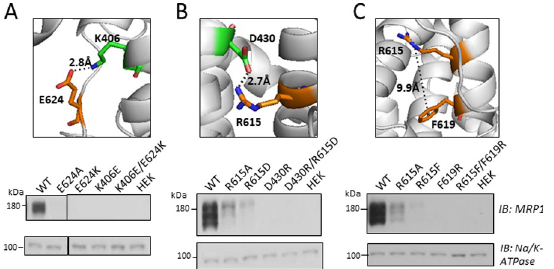
Fig 5. Potential bonding interactions of CR1 Arg 615 and Glu 624 and effect of structure-guided double exchange mutations on MRP1 levels. Upper panels , Shown are potential electrostatic bonding interactions between (A) Lys 406 and Glu 624 ; and (B) Arg 615 and Asp 430 , and (C) Arg 615 and Phe 619 derived from an atomic homology model of human MRP1 [43] based on the apo bovine Mrp1 cryo-EM structure (PDB ID: 5UJ9). While several bonding interactions are theoretically possible, for clarity, only the potential bond ( dotted line ) with the shortest predicted distance between each pair of amino acids is shown. Side chains are shown as sticks and coloured by element where oxygen is red and nitrogen is blu e. Lower panels , Shown are representative immunoblots of cell extracts (10 μ g protein per lane) prepared from HEK cells transfected with (A) wild-type (WT) and mutant (E624A, E624K, K406E, K406E/E624K) MRP1 and (B) WT and mutant (R615A, R615D, D430R, D430R/R615D) MRP1; and (C) WT and mutant (R615A, R615F, F619R, R615F/F619R) pcDNA expression vectors. Extracts from untransfected cells (HEK) served as negative controls. MRP1 was detected with mAb QCRL-1 [54], and anti-Na + /K + -ATPase was used as a protein loading control. The images in each panel are from a single blot with the region between MRP1 and the loading control cropped out. The vertical black lines in (A) indicate where irrelevant lanes from the immunoblot were removed by cropping images. Similar results were obtained with extracts from two independent